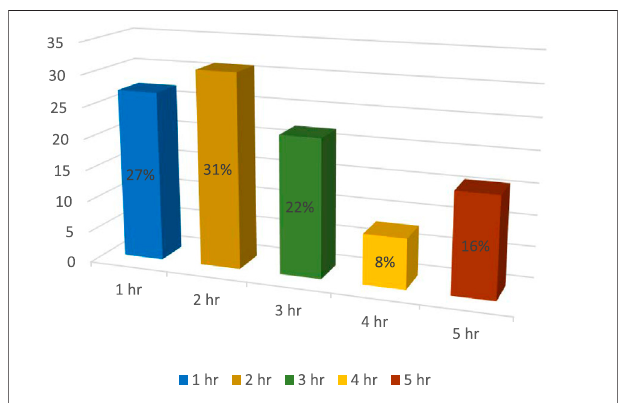
FIGURE 6 | Time spent fetching fi rewood per day by the